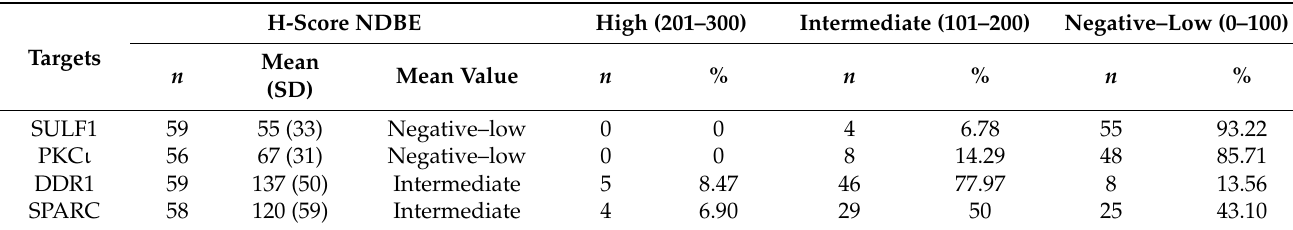
Table 2. Immunohistochemistry results of four targets in non-dysplastic Barrett’s esophagus.